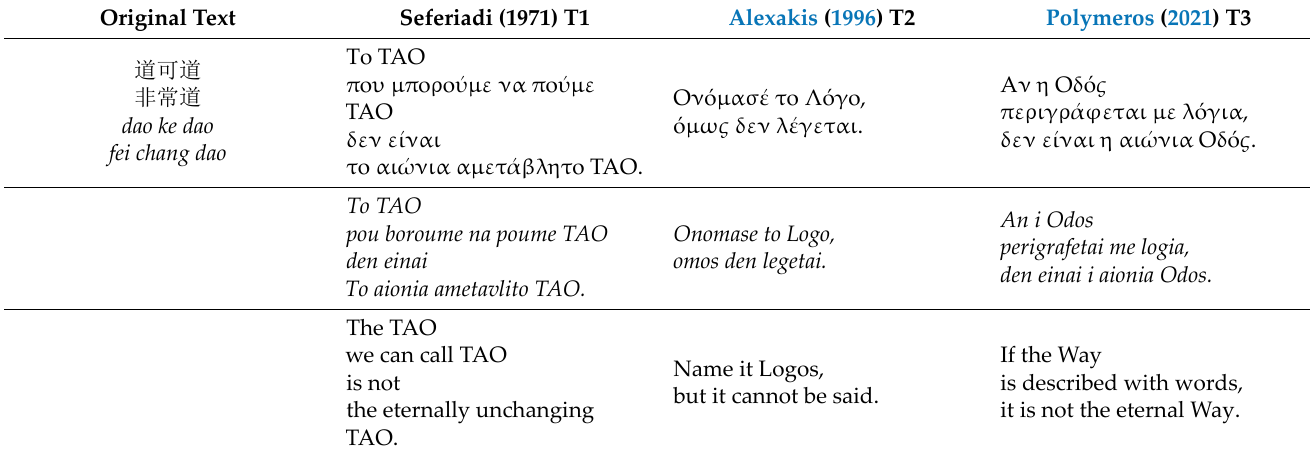
Table 1. Chapter